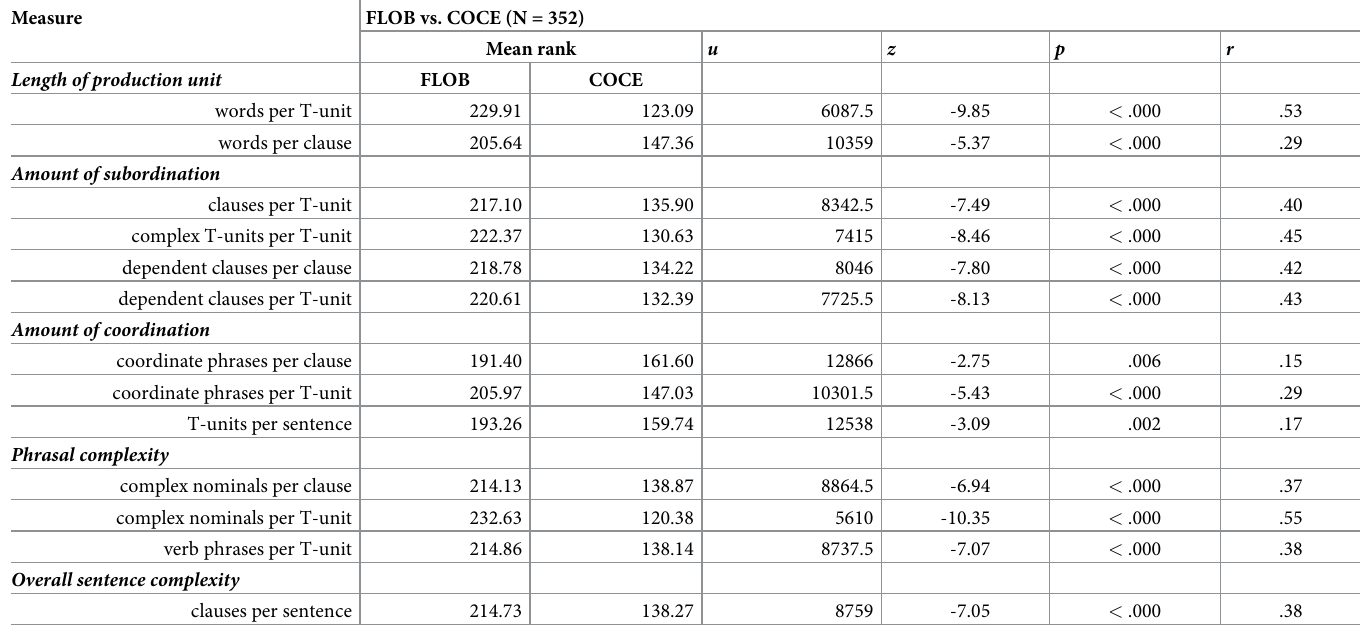
Table 7. Mann-Whitney tests on syntactic complexity between FLOB prose and COCE